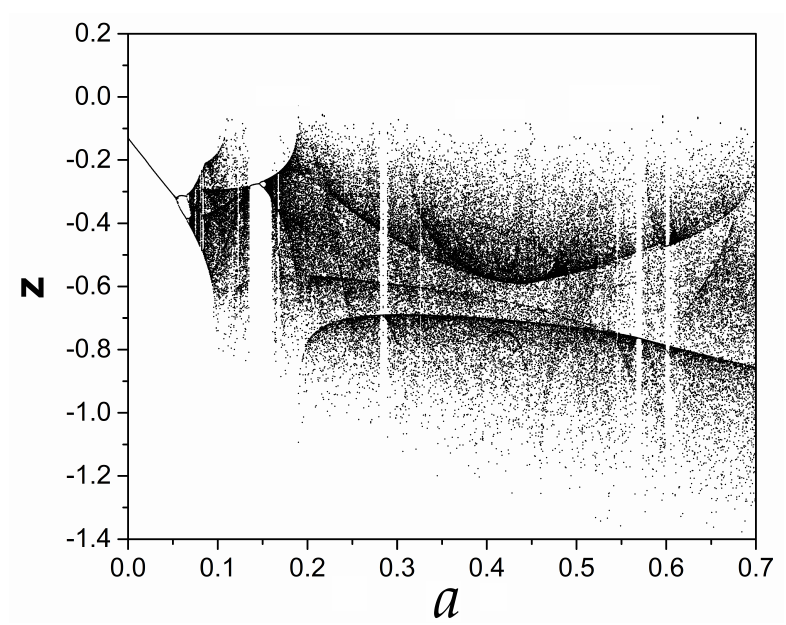
Figure 6. Bifurcation diagram of z versus a for b =